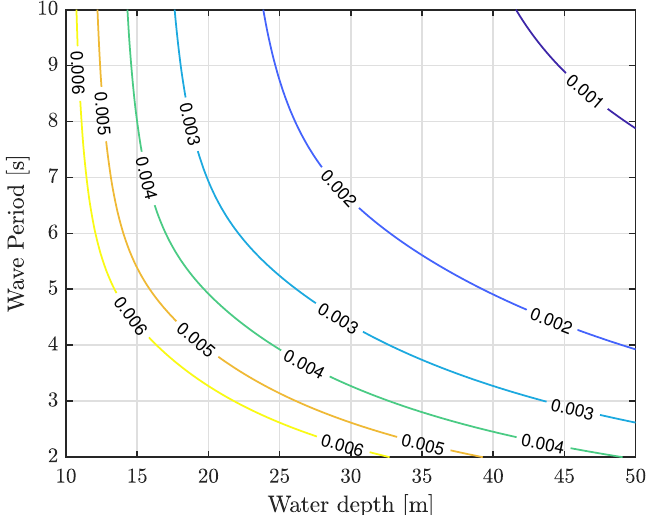
Figure 8. Contours of normalized Stokes drift current u S / H 2 s (m − 1 s − 1 ) as a function of water depth and wave